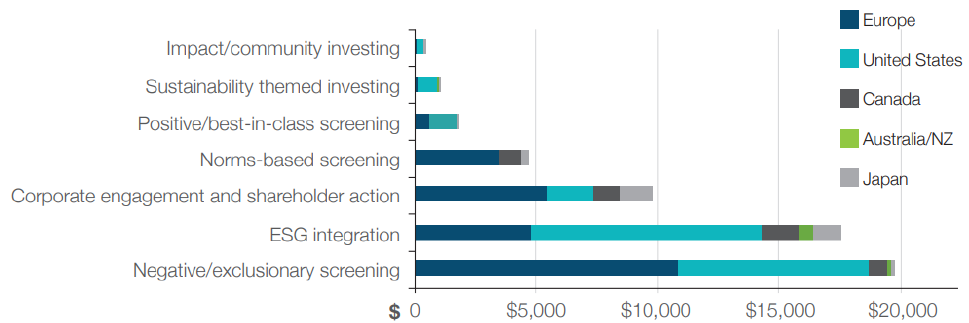
Figure A10. SRI assets by strategy and region 2018.